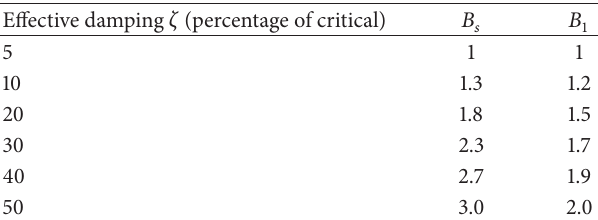
Table 5: Damping